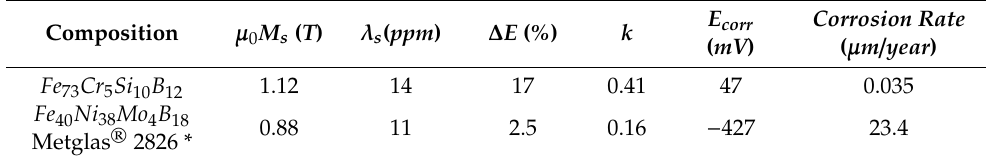
2826 alloy are also shown for comparison. Data taken from ref. [16].